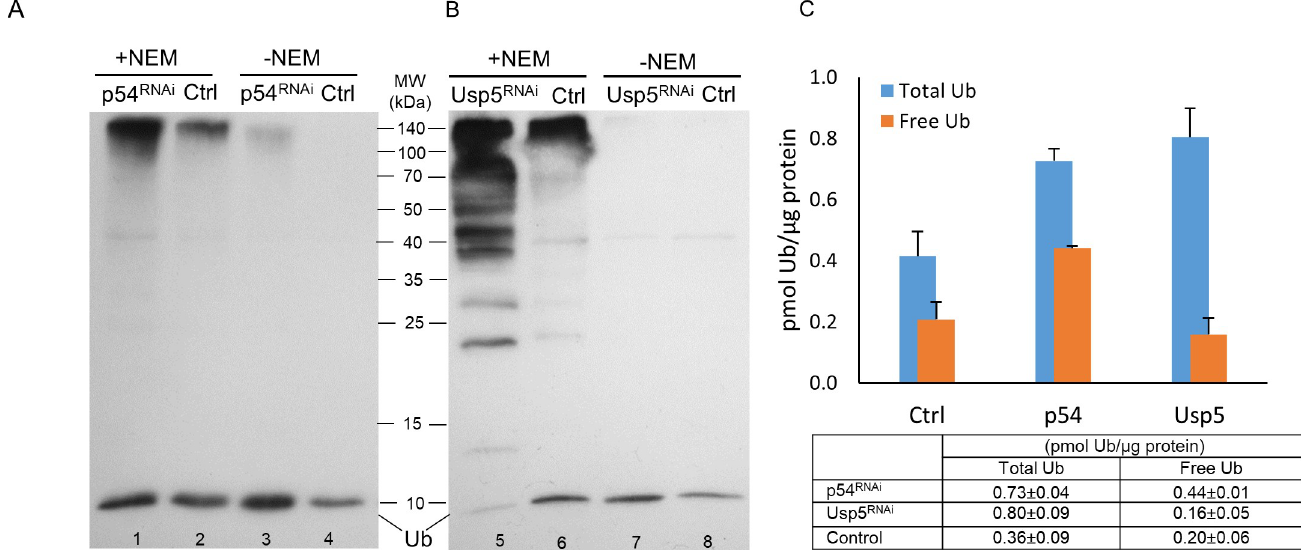
Fig 3. Effect of loss of Rpn10/p54 (A and C) proteasome subunit or Usp5 deubiquitylase (B and C) on the abundance of ubiquitin forms. Whole protein extracts in buffer F (lanes 1, 2, 5 and 6; +NEM) and buffer T (lanes 3, 4, 7 and 8; -NEM) of wandering L3 larvae were investigated by western blotting using polyclonal anti-Ub antibody at a dilution of 1:1000. The bands just below the 10 kDa mark on the immunoblots (A and B) represent free monoubiquitins, and only the intensity of these bands were determined and used for quantification. 5 μ g total protein extracts were loaded to lanes 2 and 6, while samples were diluted 1.7-fold to lanes 1 and 5; twofold to lanes 3, 4 and 8; and 3.3-fold to lane 7 before loading to avoid overloading the monoubiquitin band. Ubiquitin content (small table in C) was calculated by plotting band intensities against Ub standards and a regression line equation was generated by applying the four parameter curve fit model (R 2 = 0.9979 for Rpn10/p54 and R 2 = 0.9933 for Usp5), values were normalized to total protein content and shown as a column diagram.